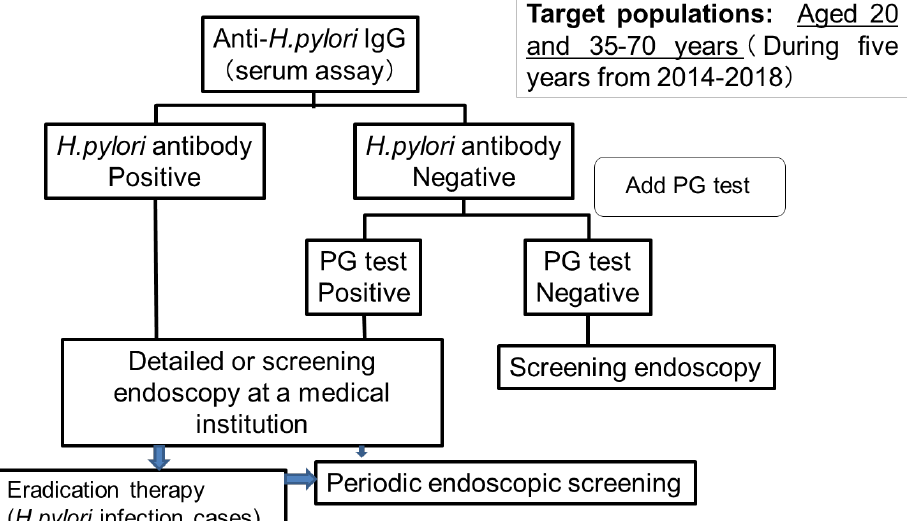
Figure 1. Flow chart of H. pylori antibody test project in Hoki-cho, Tottori prefecture. Individuals with PG I levels of ≤70 ng/mL and PG I/II ratio of <3 are classified as PG test positive, which is equal to gastric atrophy. PG, pepsinogen.